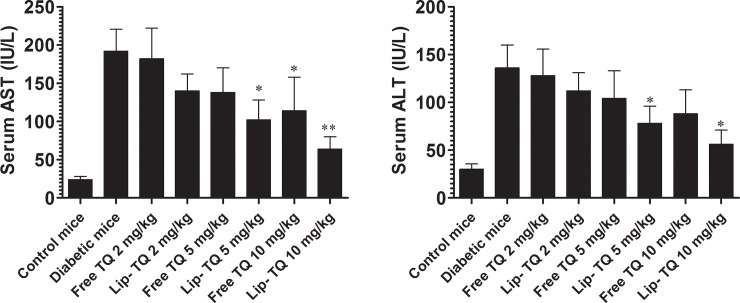
Treatment with Lip-TQ improves the liver inflammation in C. albicans infected diabetic mice.Free or Lip-TQ at the doses of 5 and 10 mg/kg were administered to treat C. albicans infected diabetic mice as described in the methodology section. On day 4th post treatment, the blood was drawn from the mice to measure the levels of (A) AST, (B) ALT. Data are expressed as mean ± SD. A P value <0.05 was considered to be significant.